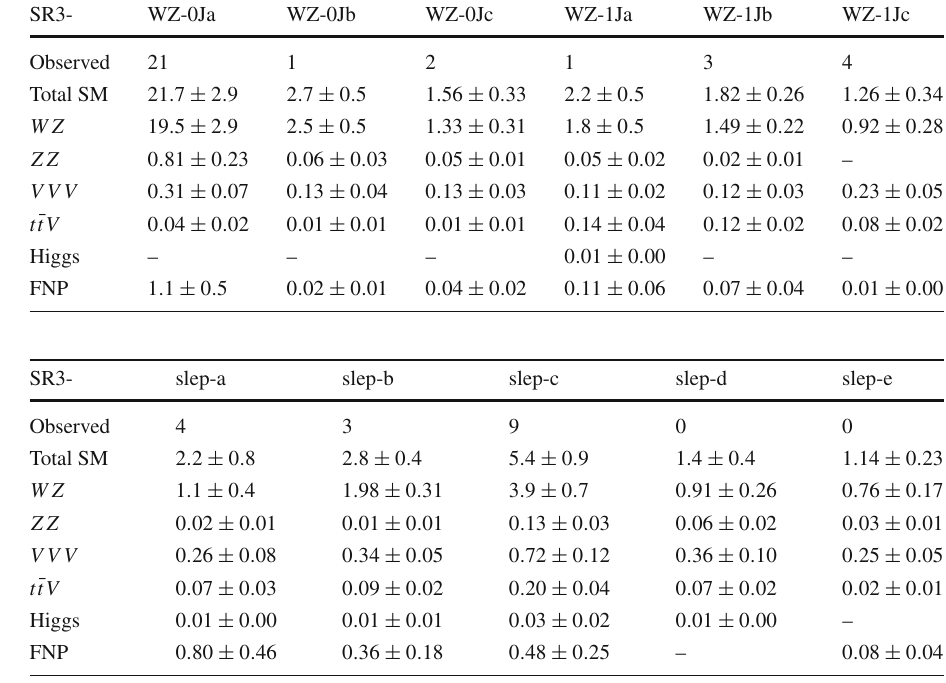
for SR3-WZ-0Ja to SR3-WZ-0Jc and SR3-WZ-1Ja to SR3-WZ-1Jc in the 3 (cid:4) channel. All systematic and statistical uncertainties are included in the fit